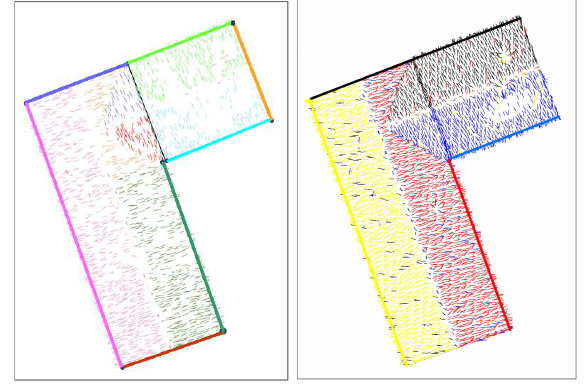
Figure 1. Height coded LiDAR-data within a building ground plan (left), Delaunay Triangulation (right)